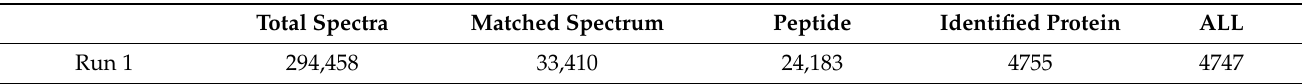
Table 4. An overview of protein